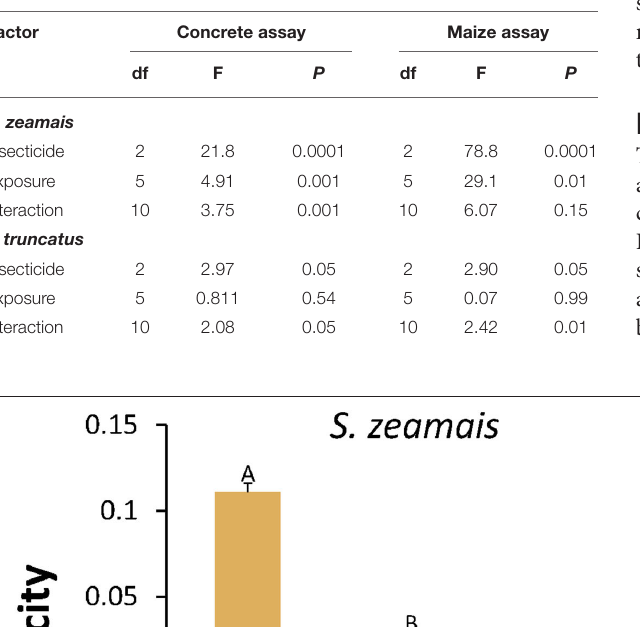
Frontiers in Agronomy |